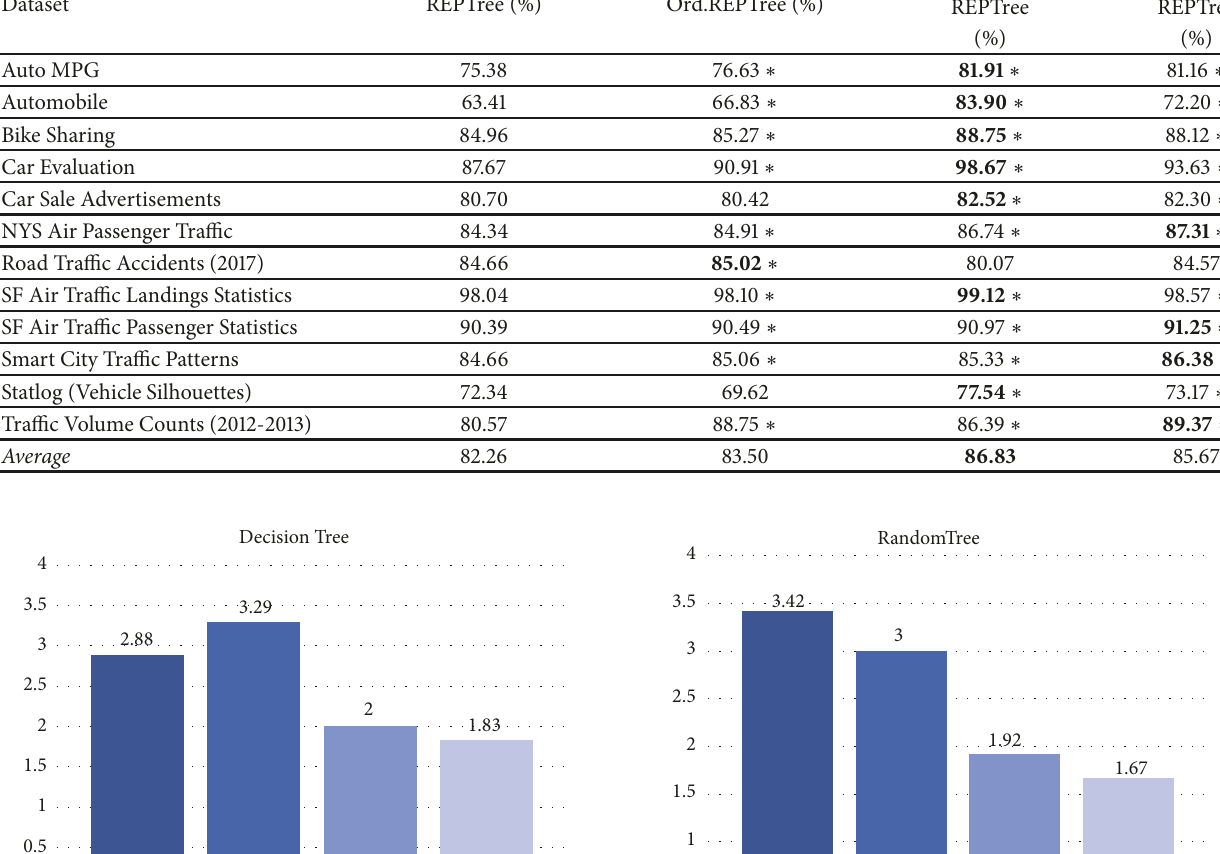
Table 5: The comparison of REPTree based ordinal and ensemble learning methods in terms of classification accuracy. Dataset